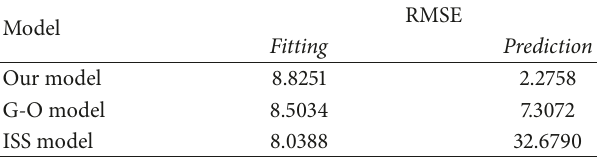
Table 2: Fitting and prediction results of three